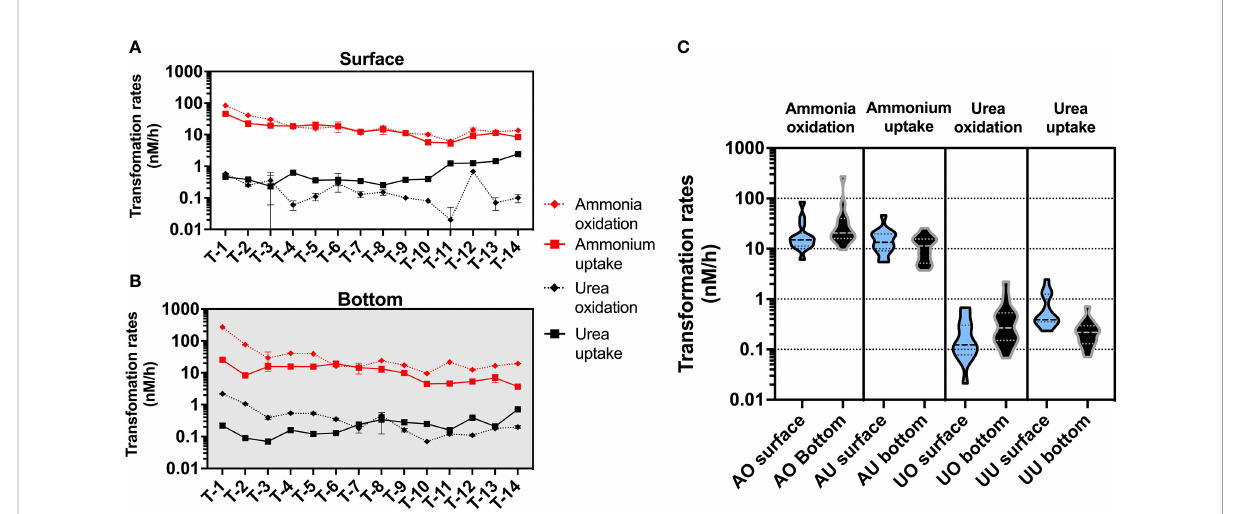
FIGURE 4 Magnitude distribution of different N transformation rates (nM/h) in the surface (A) and bottom (B) layers, with red and black representing ammonium and urea transformation rates, respectively. Sub fi gure (C) shows violin plots for different rates (AO, ammonia oxidation; AU, ammonium uptake; UO, urea oxidation; UU, urea uptake), with blue representing rates in the surface layer and black representing rates in the bottom